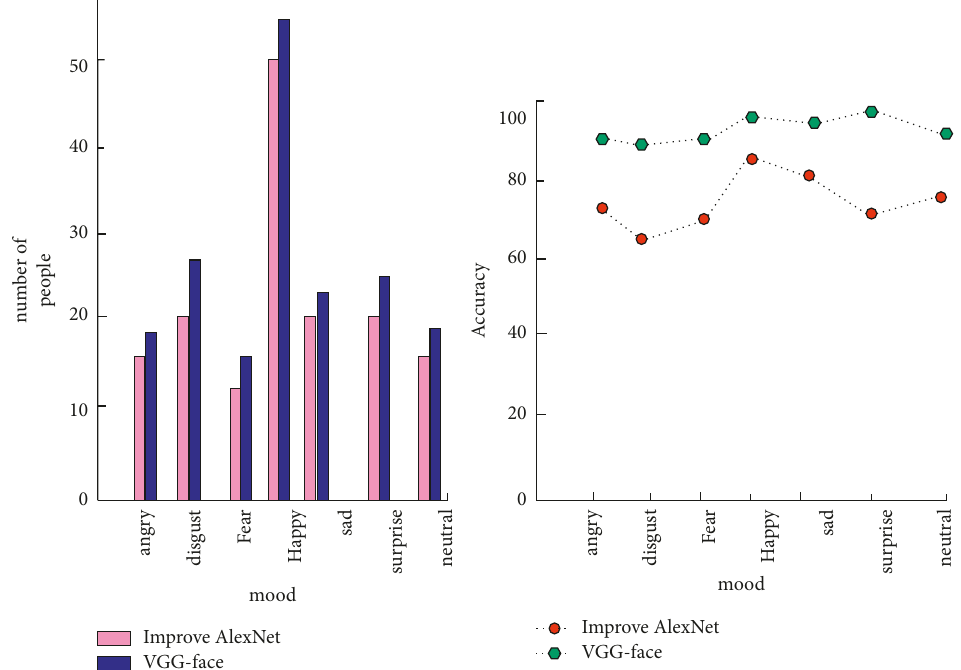
Figure 8: Two methods of identification